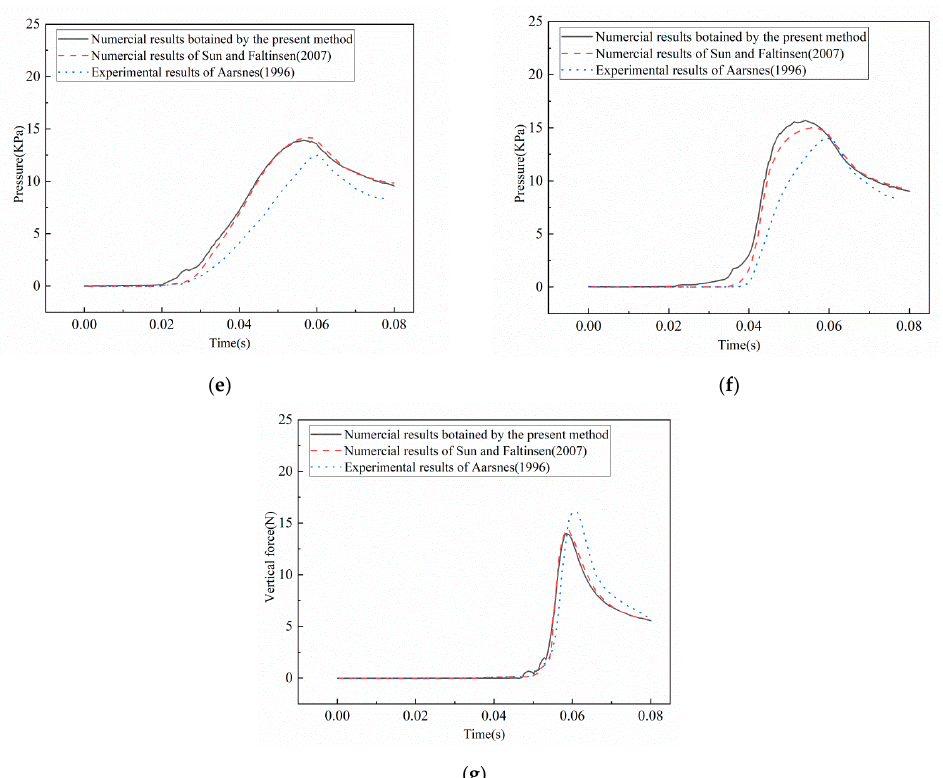
Figure 8. Comparison between experimental results of Aarsnes (1996) and numerical results: ( a ) force; ( b ) velocity; ( c ) acceleration; ( d ) P4; ( e ) P5; ( f ) P6; ( g ) P7.